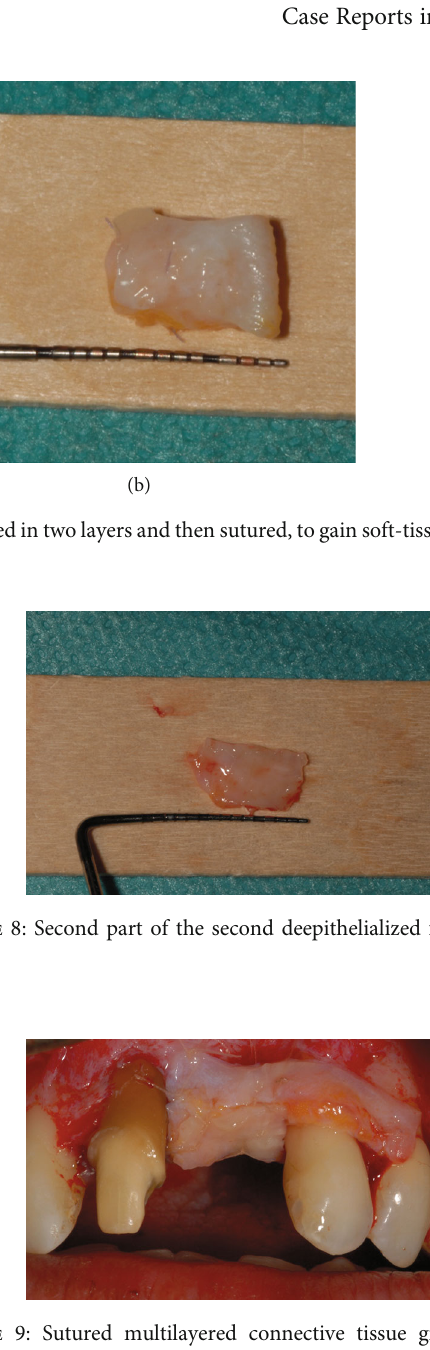
Figure 6: Second deepithelialized free gingival graft.